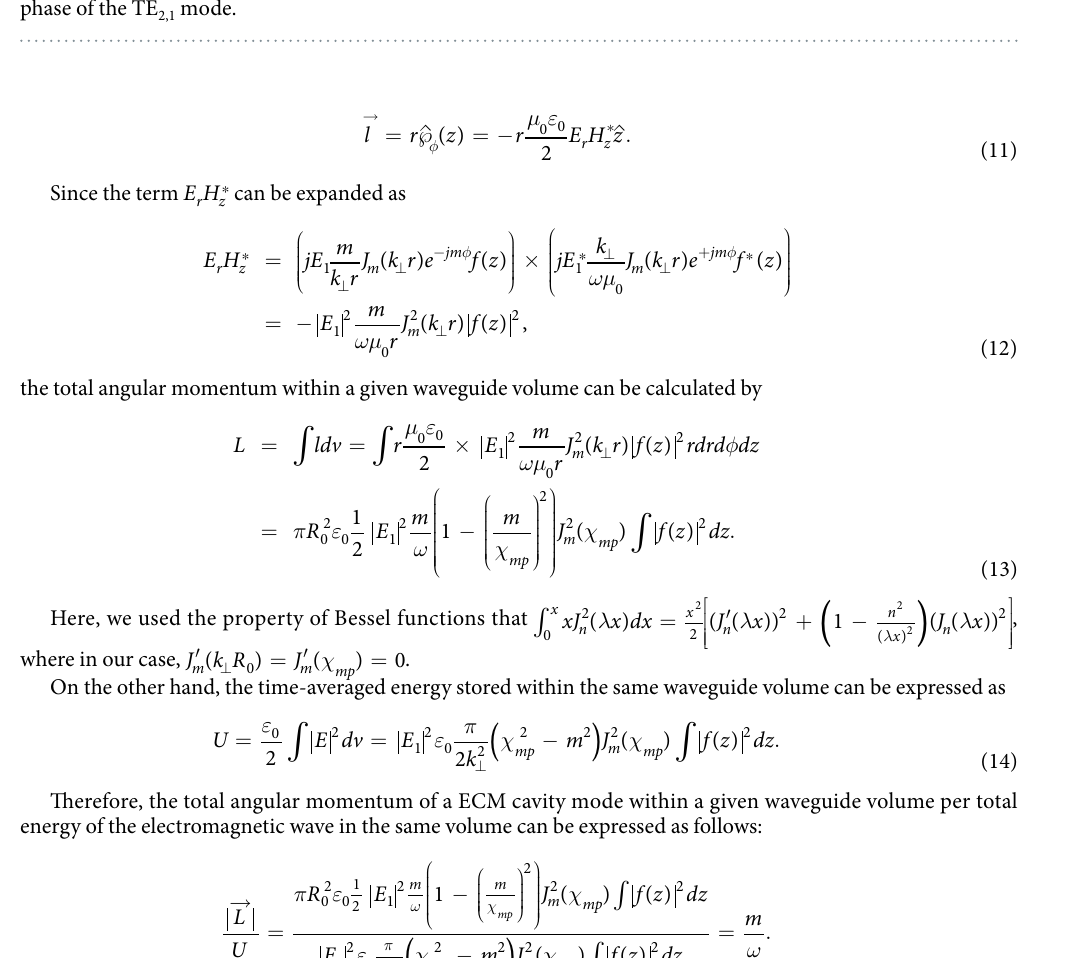
Figure 3. ( a ) Spin angular momentum (SAM). ( b ) Orbital angular momentum (OAM). ( c ) Amplitude and ( d ) phase of the TE 2,1